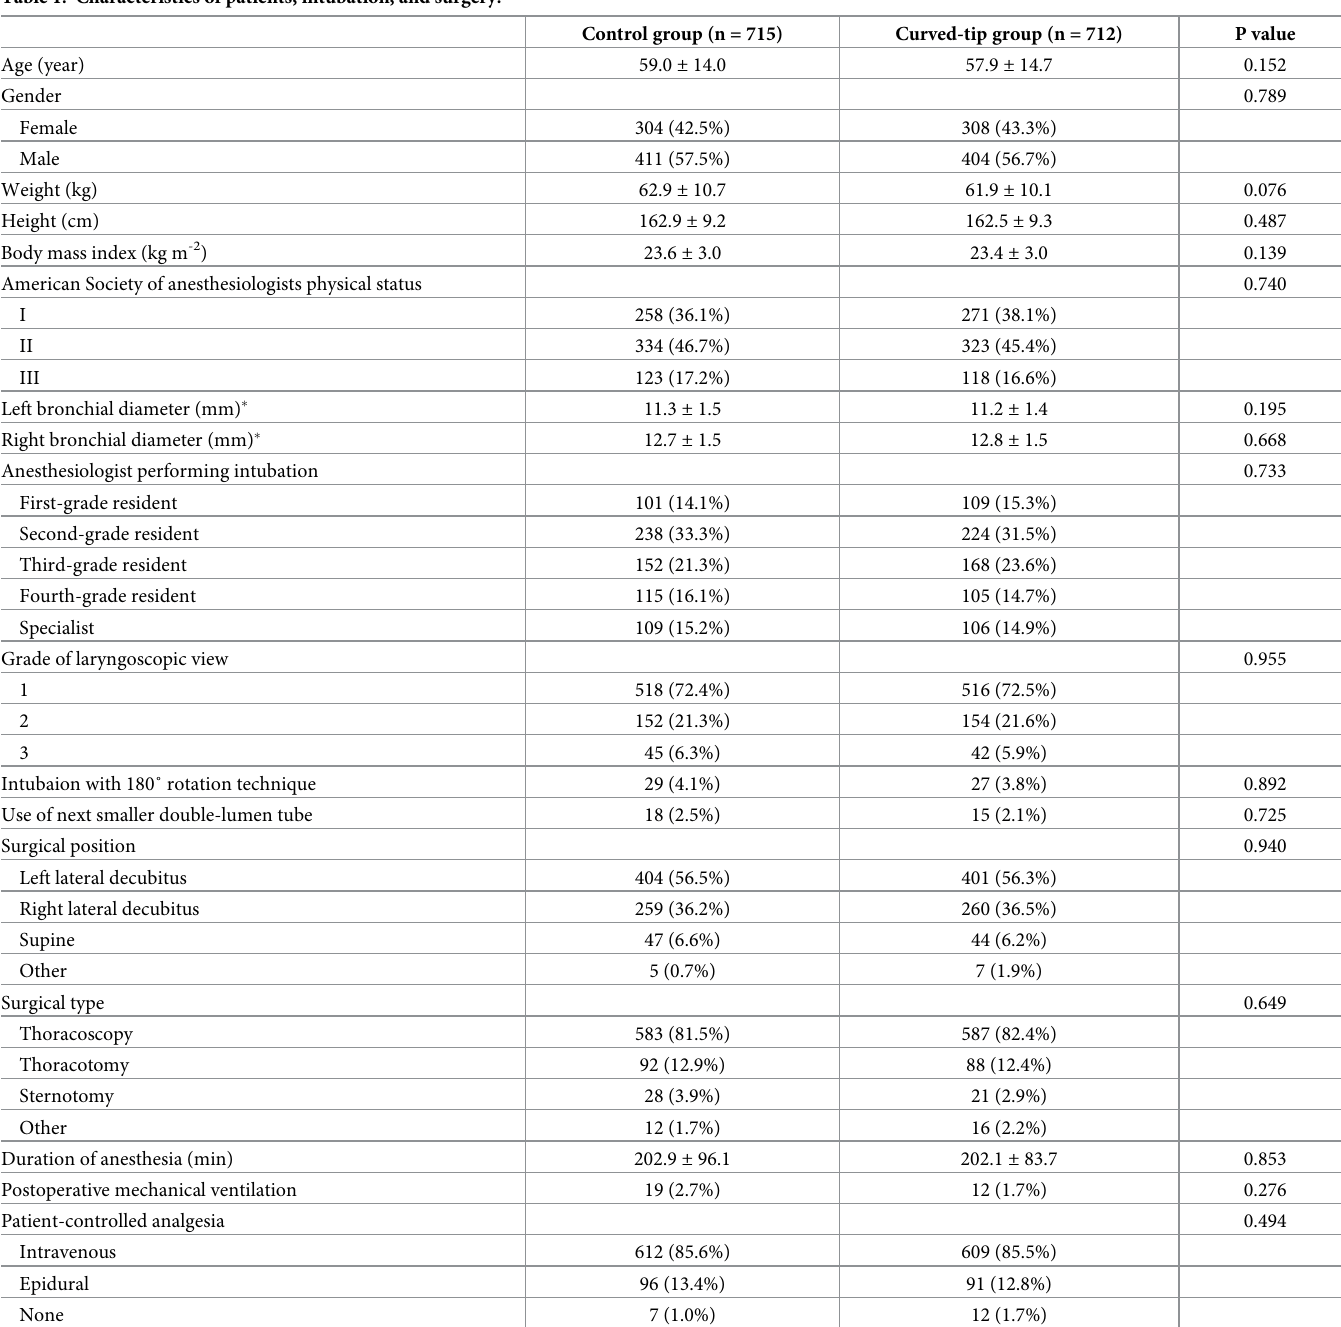
Table 1. Characteristics of patients, intubation, and